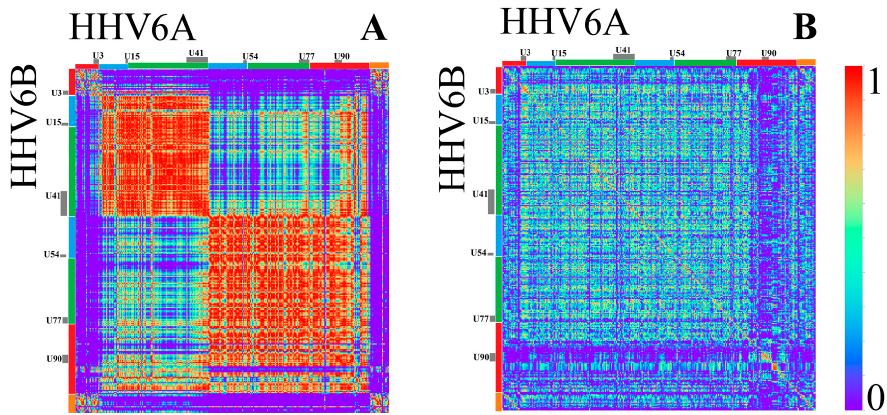
Figure 9. Correlation heatmap between HHV6A and 6B for k = 1 ( A ) and relative k = 2 ( B ) (bin width 500 bp). Genes are represented by grey bars at the borders. Regions with a low identity score in [22] are marked orange, extremely low values are red, high identity scores are blue, and extremely high values are green.